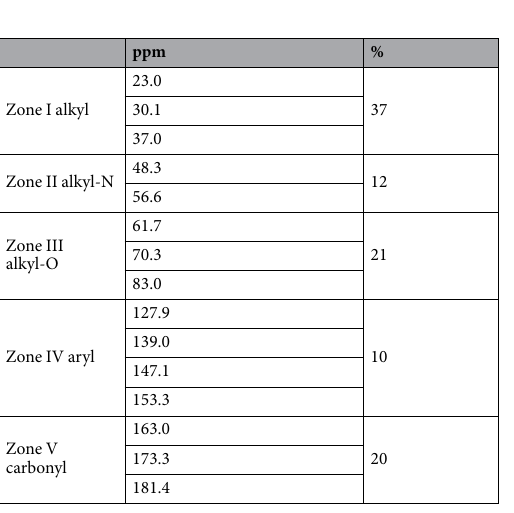
Table 1. Proportions of the main chemical categories of phytC occluded within the TD-F-L